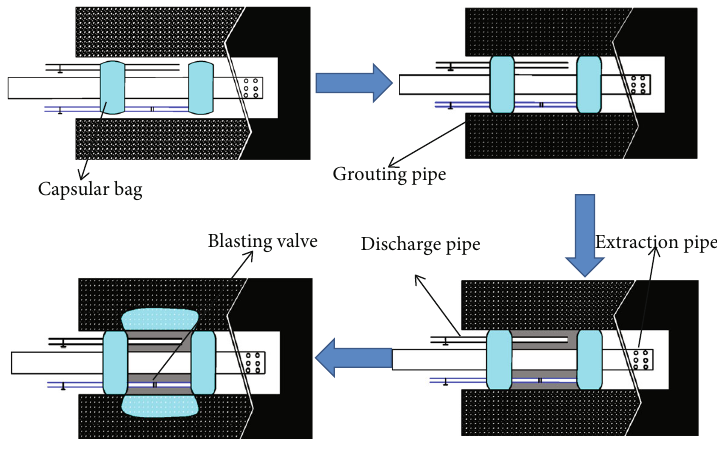
Figure 10: Hole-sealing